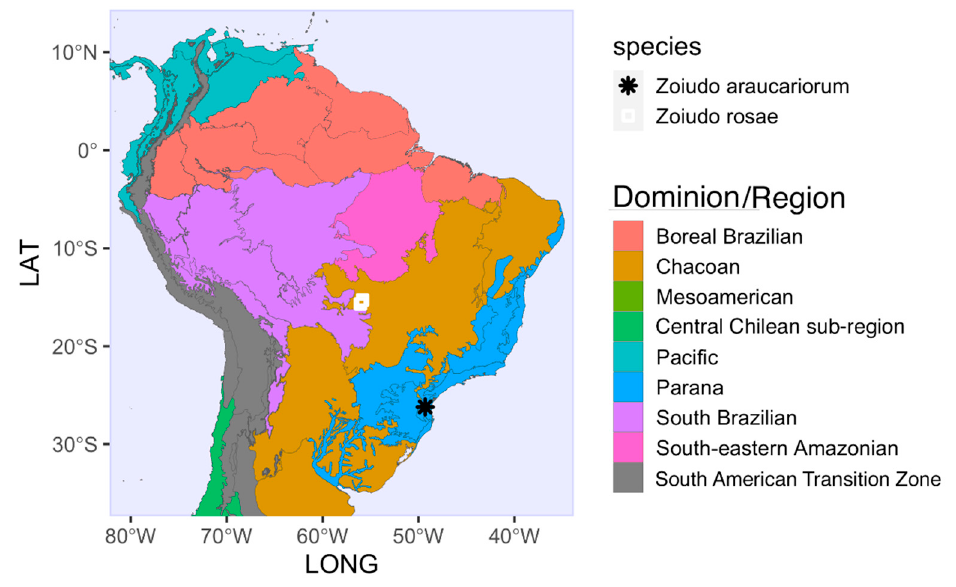
Figure 10. Distribution range of Zoiudo gen. nov. and its two species, on a map superimposed with the dominions as in Morrone et al., 2022.